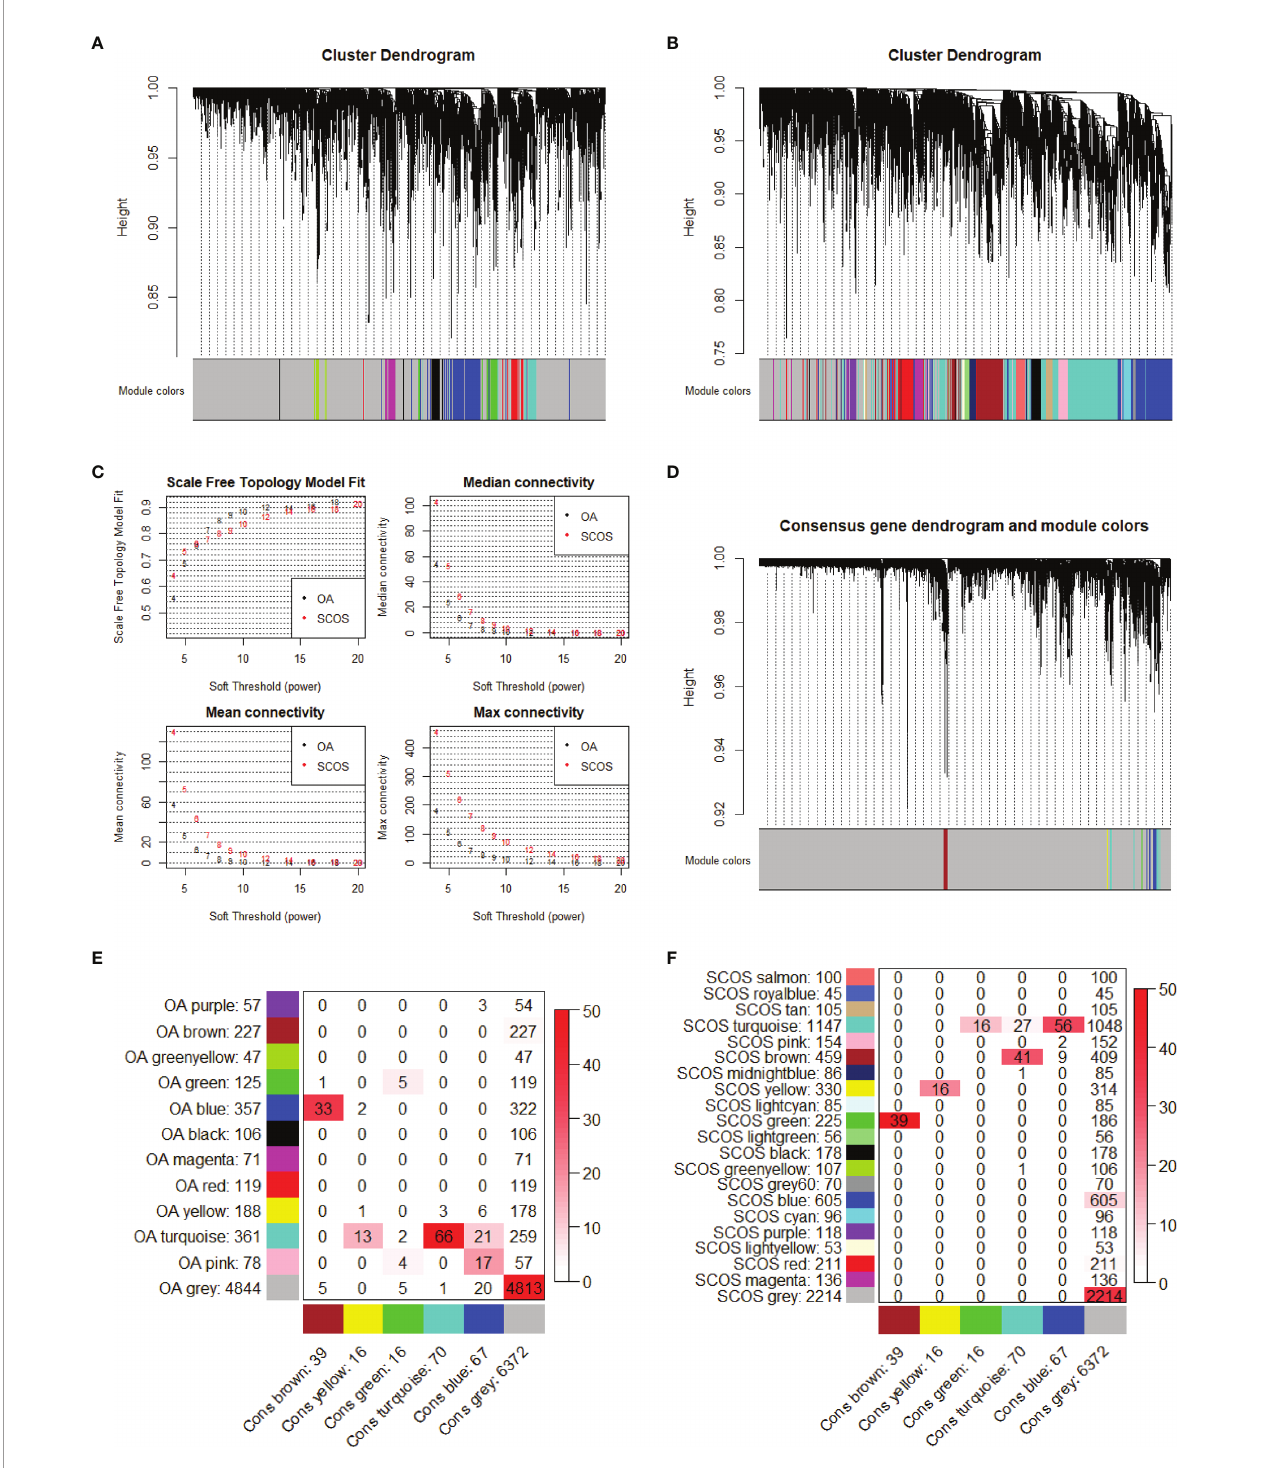
FIGURE 7 | Network construction in each group and consensus module analysis. Cluster dendrograms of (A) OA and (B) SCOS modules. (C) Soft threshold and network connectivity. The networks of OA and SCOS groups formed a scale-free network, in which median, mean, or max connectivity indicated node connectivity. (D) Cluster dendrogram of the OA-SCOS consensus modules. (E) Correspondence of OA-speci fi c modules and the OA-SCOS consensus modules. (F) Correspondence of SCOS-speci fi c modules and the OA-SCOS consensus modules. The number in each small square means gene counts. A stronger red color suggests more signi fi cant overlap. OA, obstructive azoospermia; SCOS, Sertoli cell-only